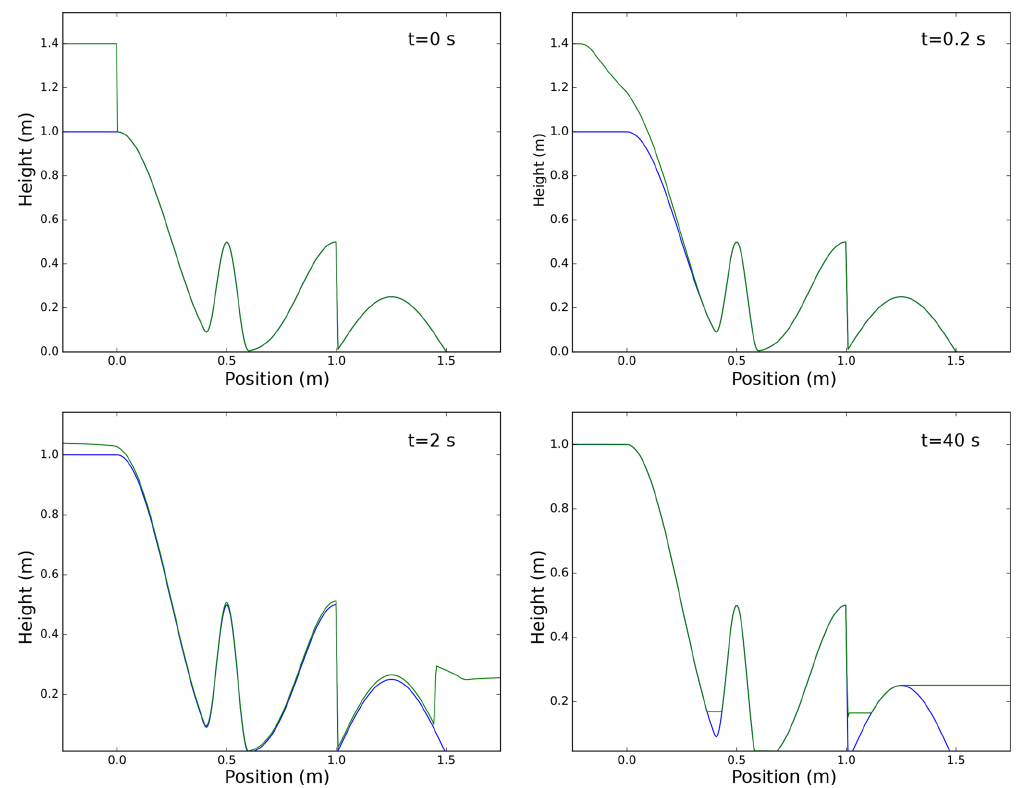
Figure 3. Numerical solution of a 1-D Riemann problem with friction at four different times. The solid blue line represents the topography, while the solid green line represents the free surface of the wet